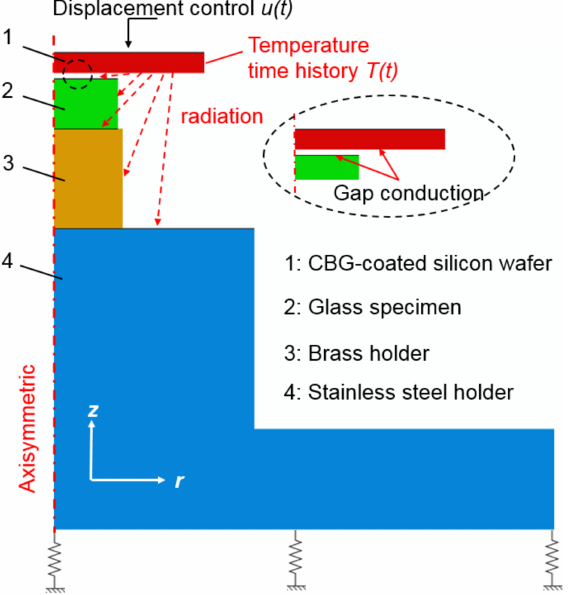
Figure 6. Axisymmetric finite element model for simulating the hot embossing